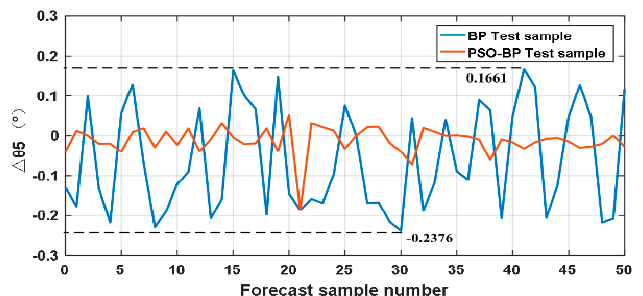
Figure 11. Error contrast of test set’s θ 5 .